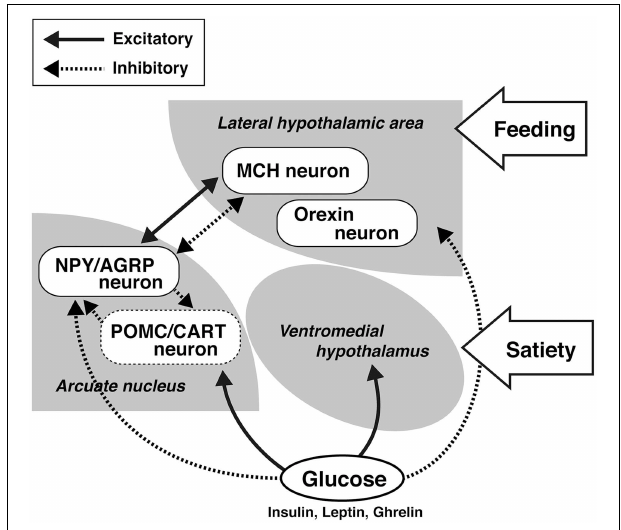
FIGURE 1 | Schematic of the control of feeding by glucose in the hypothalamus.